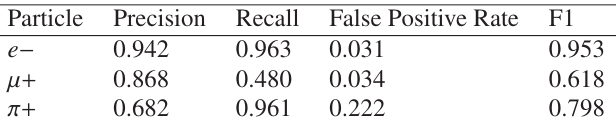
Table 3. Performance on three particles classification.